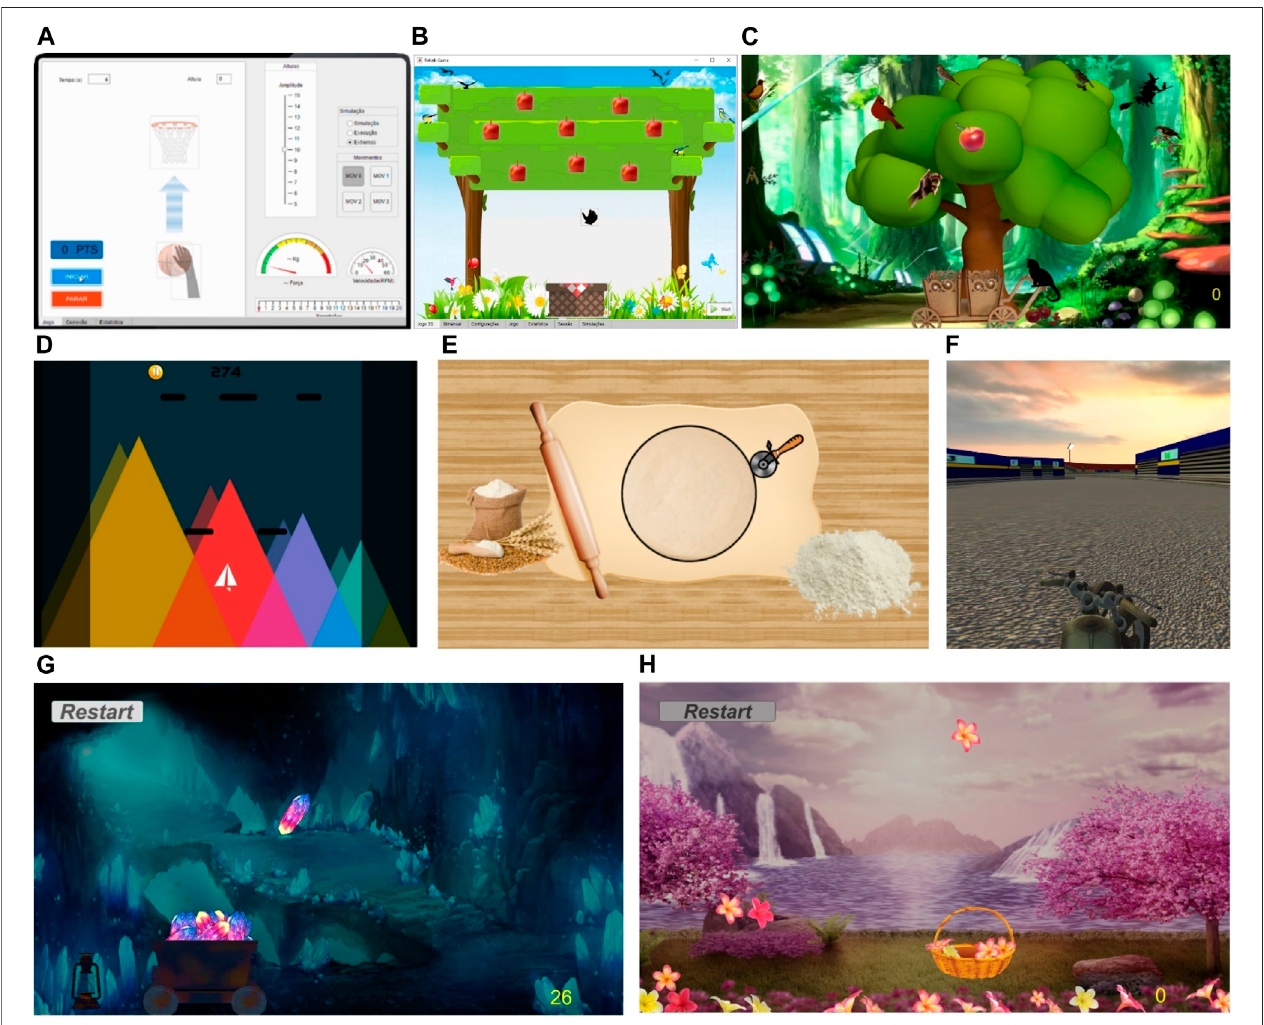
FIGURE6 | Mainscreen ofthe serious games: (A) Rehab Basketball, (B) SquareApple, (C) Grabbing Apple, (D) Paper Plane (escape mode), (E) Round Pizza, (F) Motorcycle, (G) MineCart, and (H) Sakura Flowers.